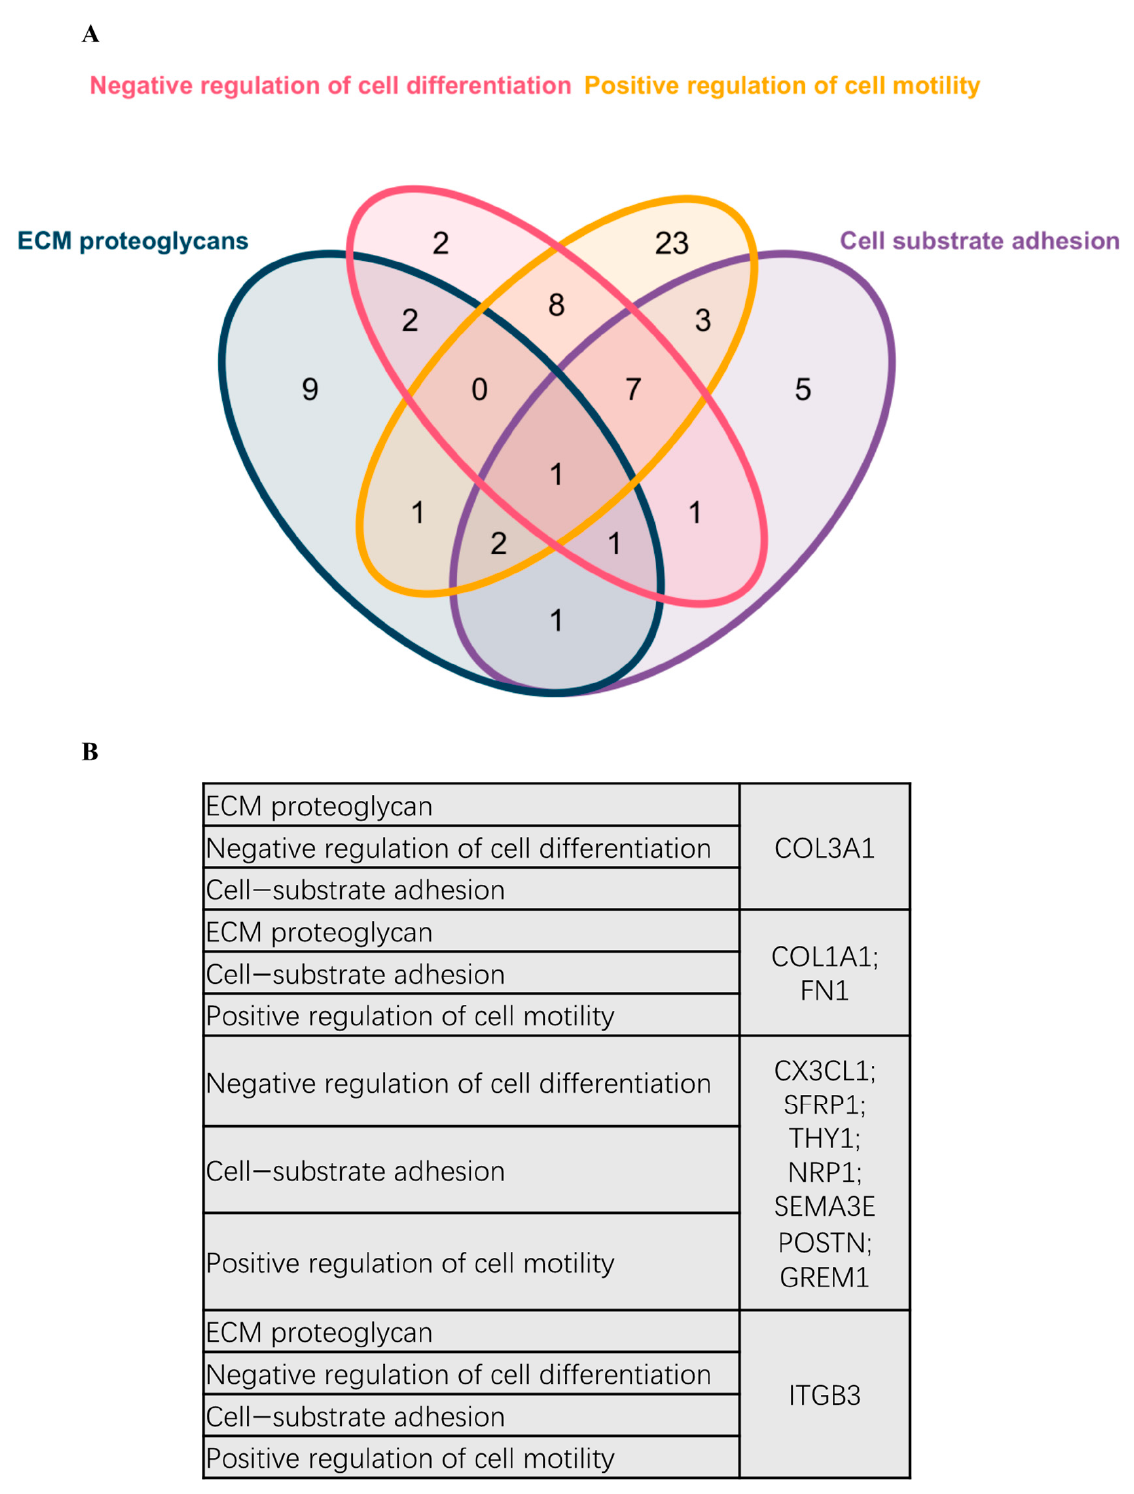
Figure 5. Venn diagram representing overlapping DEGs in different pathways and biological processes. ( A ) Venn diagram representing overlapping DEGs in different pathways and biological processes. ( B ) Scoring references list representing the detailed DEGs involved in the Venn diagram.